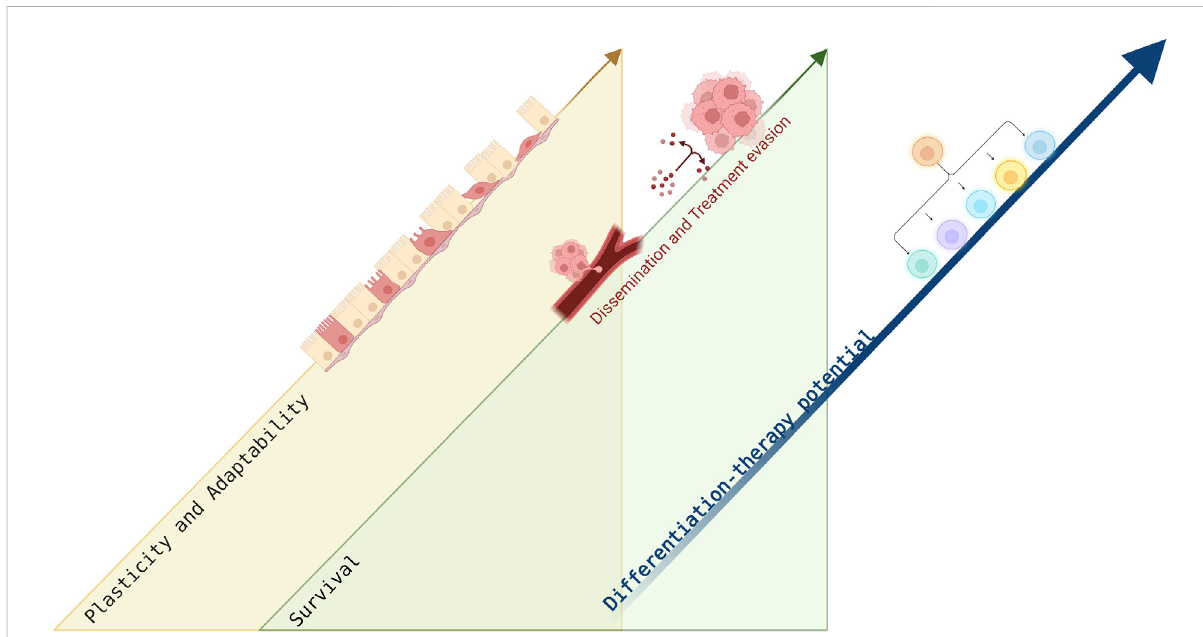
FIGURE 3 Differentiation treatment potential facilitated by cancer plasticity. This fi gure schematically illustrates the concurrency of cell plasticity and cancer survival during malignant progression with the differentiation potential. When cancer cells are responding to stress induced by the changing microenvironment during dissemination or in response to treatment application, cell plasticity and adaptability are enhanced, correlating with cell survival. The increased cell plasticity is linked to the multi-differentiation potential of the cells, proposing a therapeutic window. Figure created with